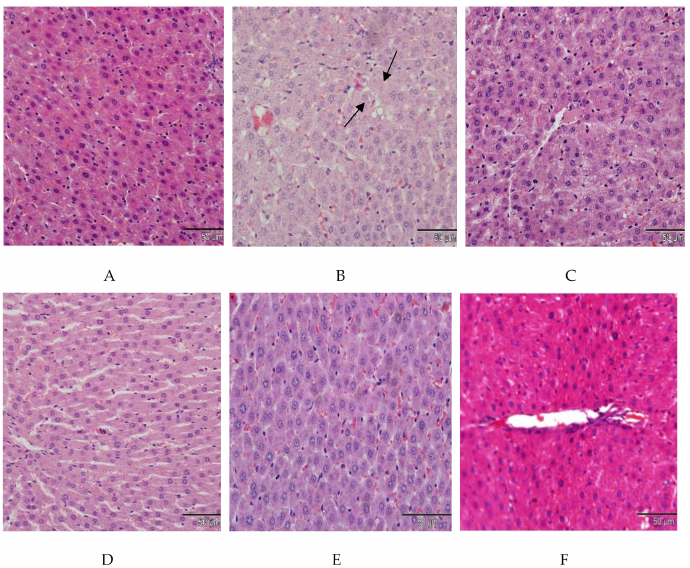
Figure 2. Histopathological analysis of liver (scale bar 50 µ m) for the ( A ) NC group, ( B ) PC group, ( C ) DC group, ( D ) T I group, ( E ) T II group, and ( F ) T III group. NC: normal control; PC: positive control; DC: drug control; T I: treatment 1 (10 mg · kg − 1 ); T II: treatment 2 (100 mg · kg − 1 ); T III: treatment 3 (200 mg · kg − 1 ).